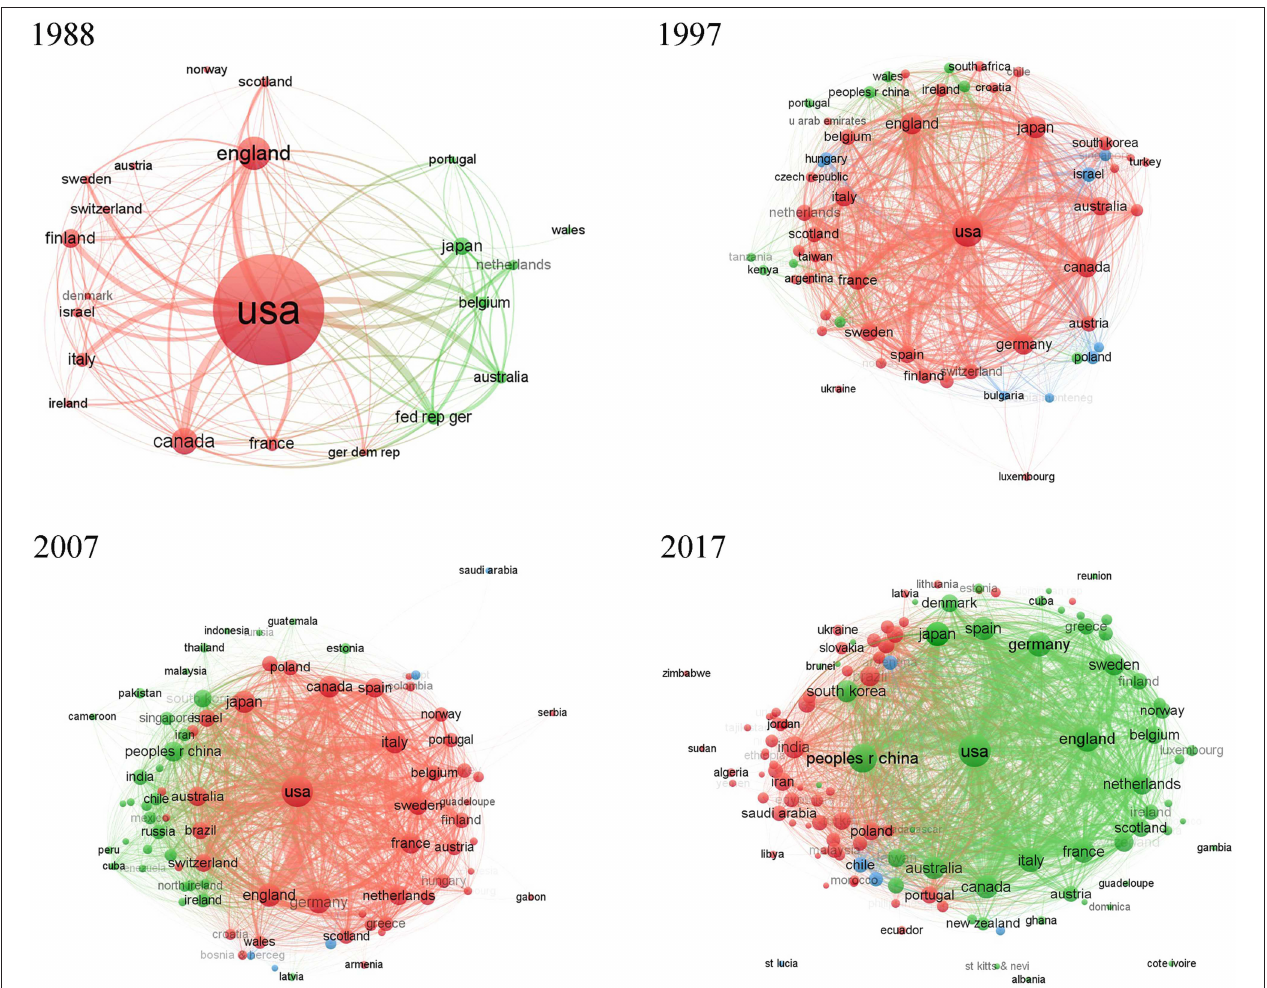
FIGURE 5 | Global countries and regions maps. In this visualized network, each country or region is represented by a node. Node size reflects the number of publications in the node, and two nodes are connected by a curved line if either of them cites the other. Curved lines between nodes reflect the connectivity of nodes, with line thickness representing the number of citations between two nodes. VOSviewer has its own clustering technique based on citation relations between clusters. Colors represent groups of nodes that are relatively strongly related to each